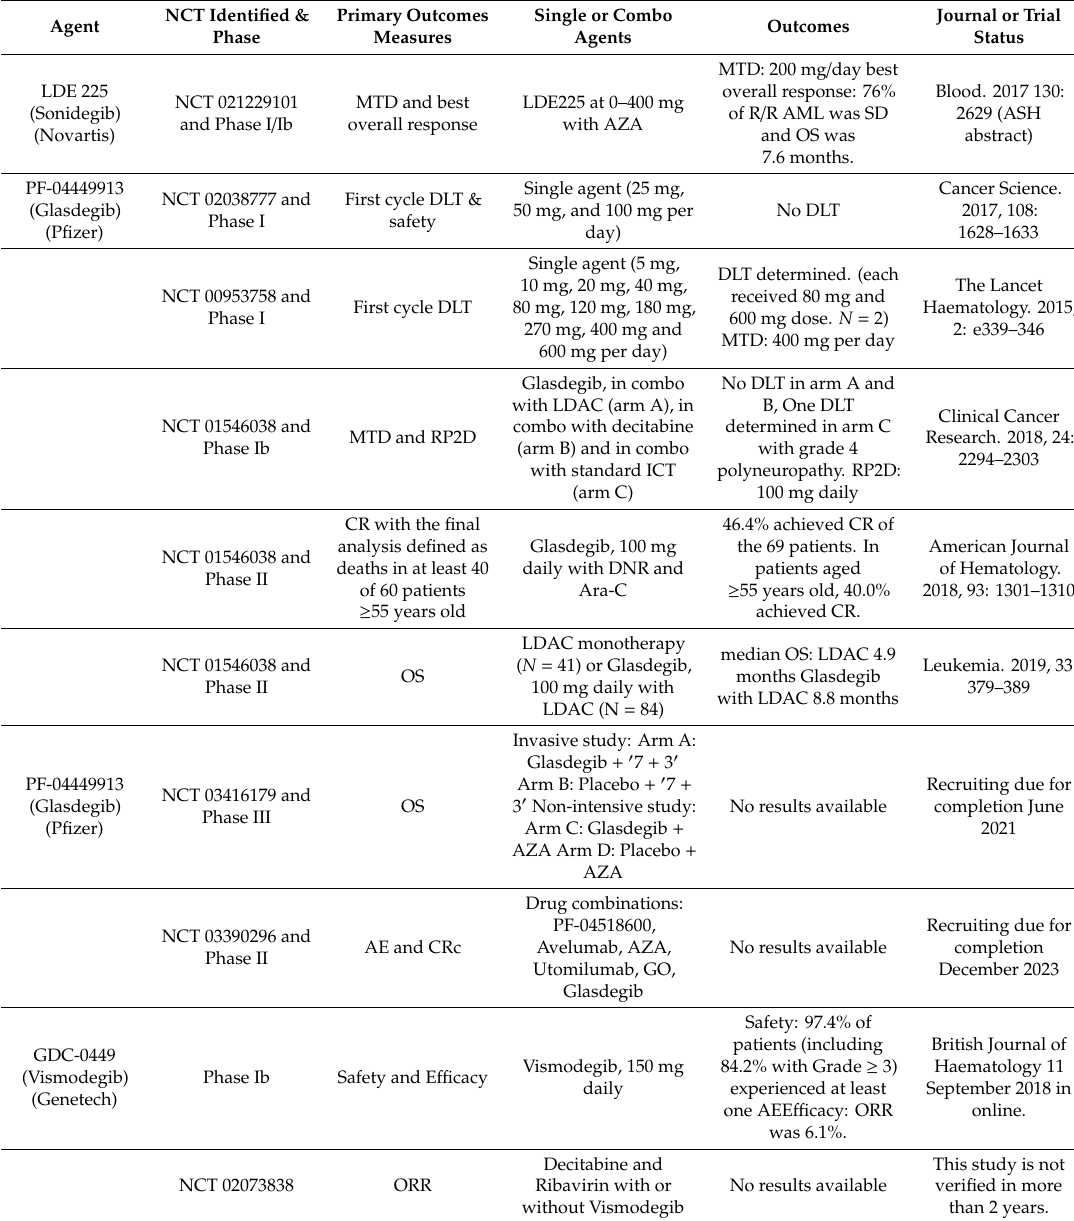
Table 1. Representative clinical trials of Hh-pathway-targeted agents in